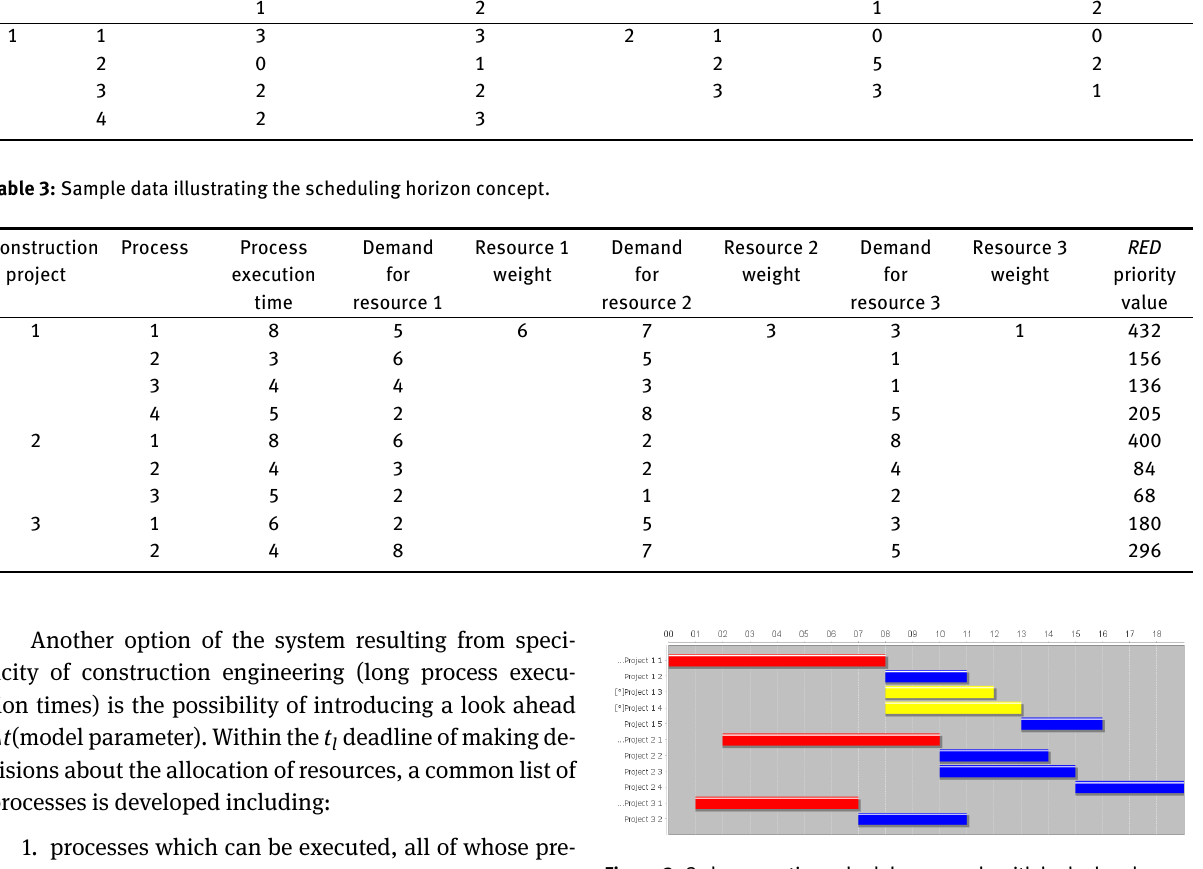
Figure 3: Order execution schedule - example with look-ahead; decision on resource allocation made within deadline t l = 3